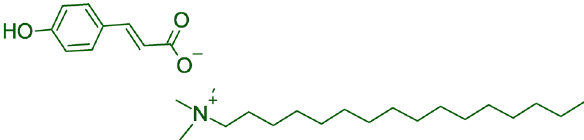
Figure 1. The molecular structure of CTA-4OHcinn used in this study.